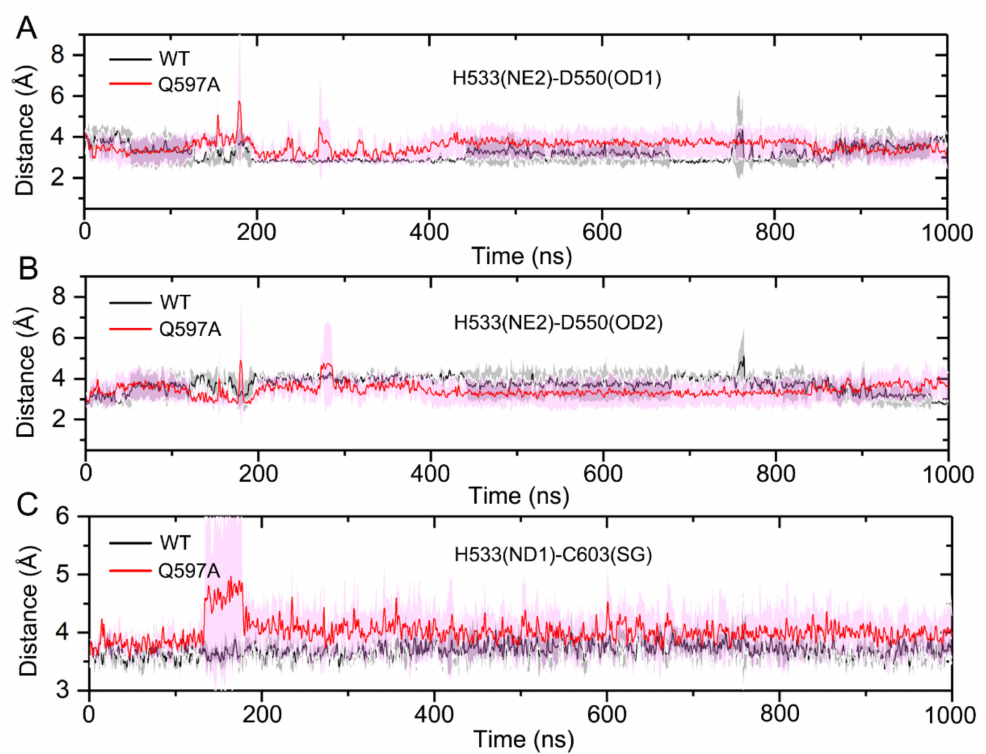
Figure 7. Time-dependence of the distances between the NE2 atom of His533 and the OD1 atom of Asp550 ( A ), the NE2 atom of His533 and the OD1 atom of Asp550 ( B ), and the ND1 atom of His533 and the SG atom of Cys603 ( C ) for three independent runs with standard deviation represented by transparent